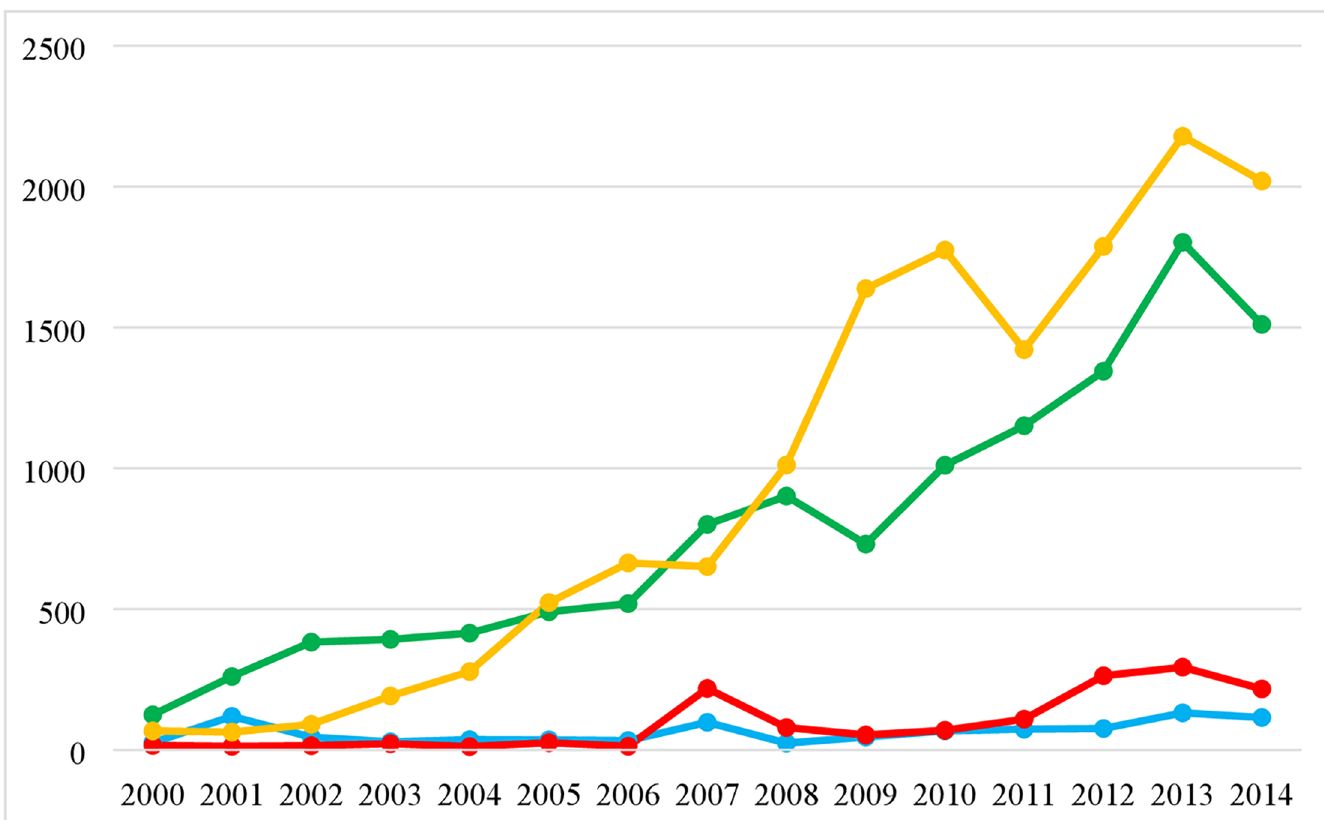
Fig 5. Upper-bound estimatesof aid disbursed to projects with specific indications on listed.